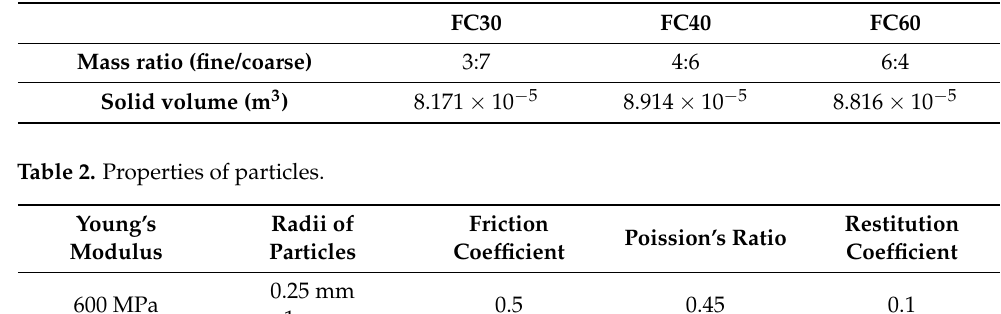
Table 1. The information of specimens.